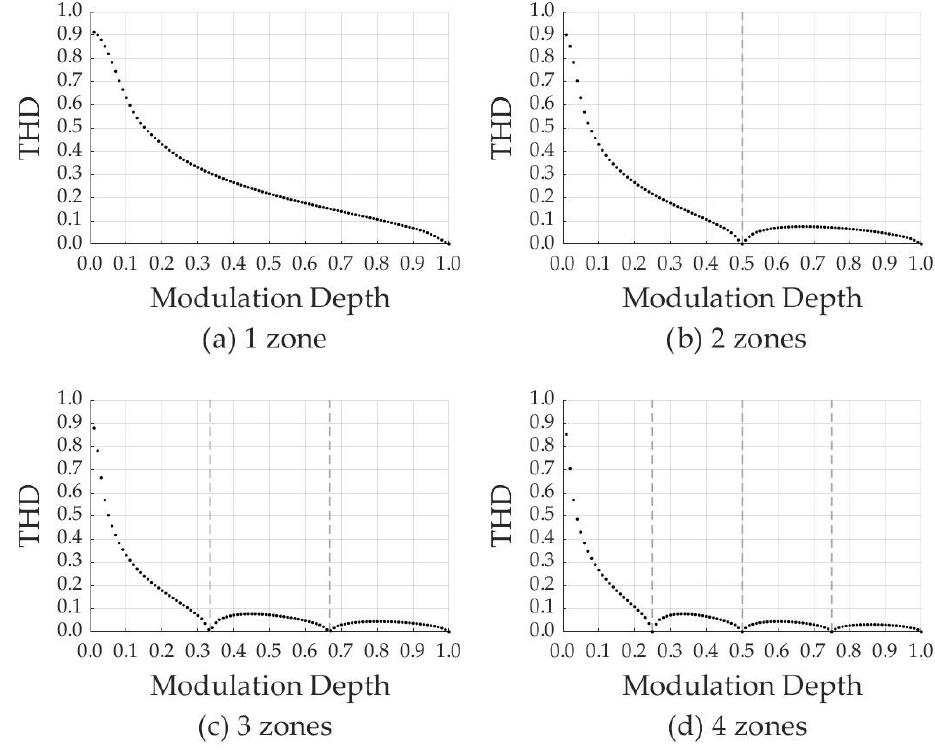
Figure 5. THD Characteristics (dependences of THD on modulation depth) of 1 zone (a), 2 zones (b), 3 zones (c) and 4 zones (d) converter topology.